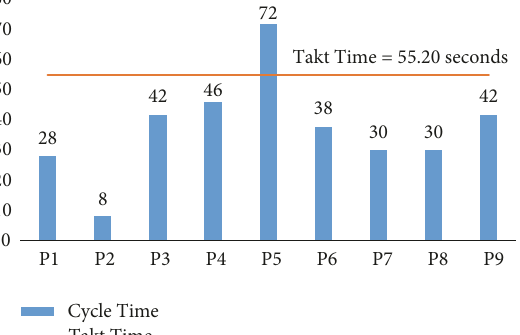
Figure 4: Cycle time and takt time for the processes.